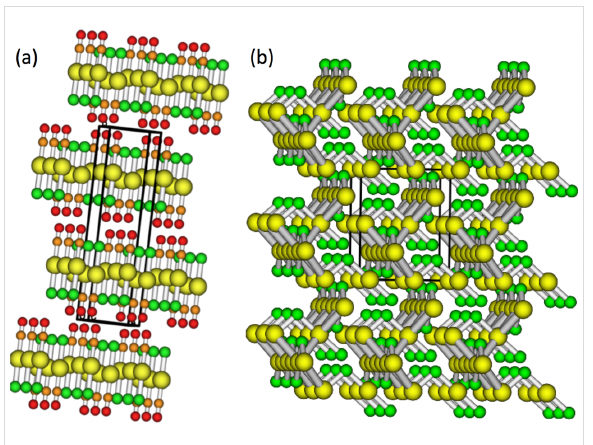
Figure 8: Periodic structure calculations for crystal structures of (a) ClAuCO and (b)